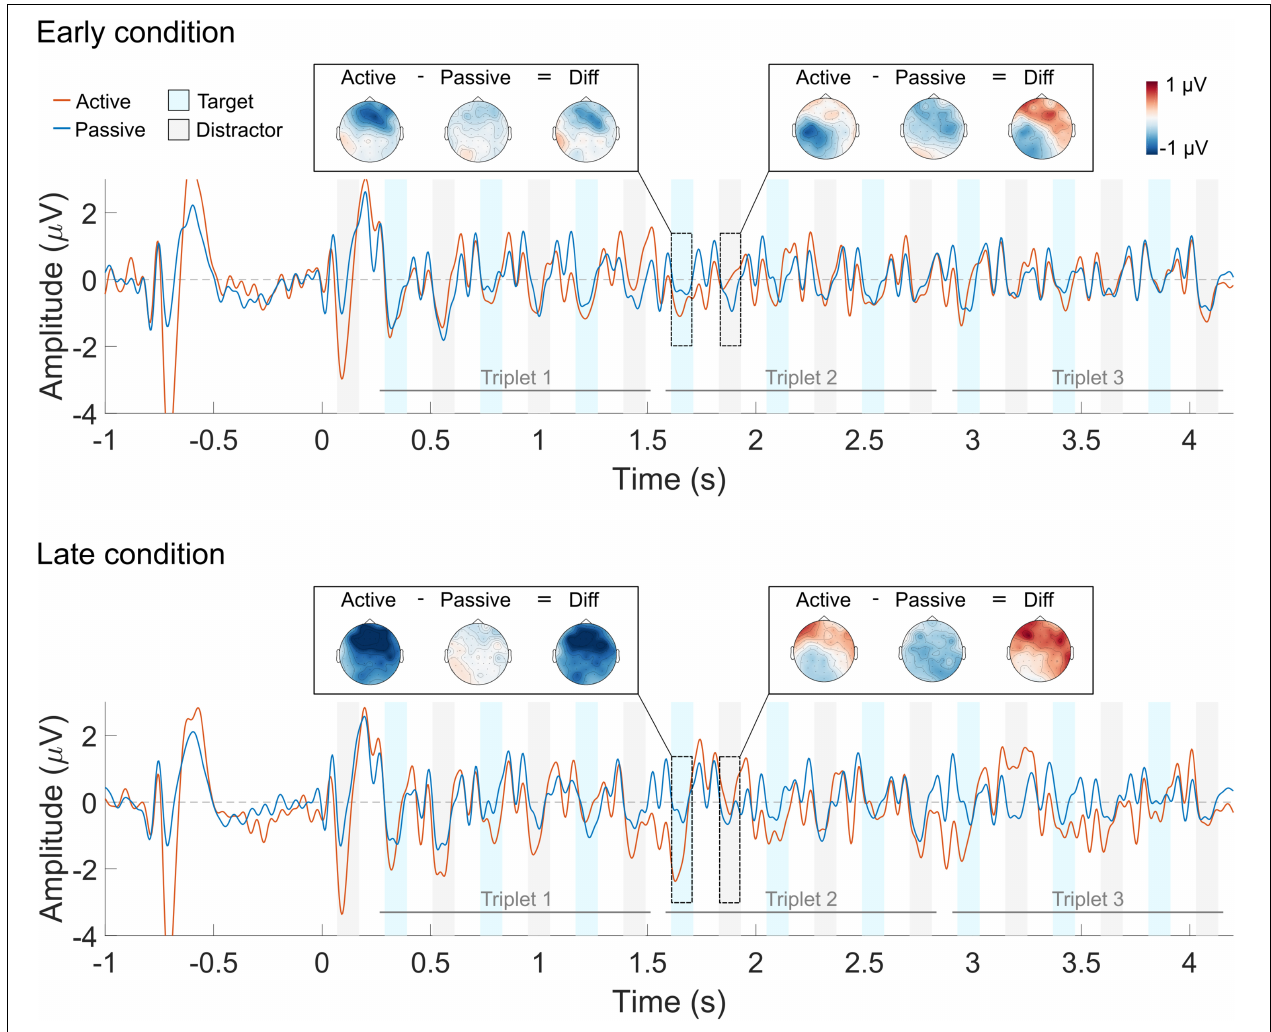
FIGURE 5 | Averaged ERP waveform for the early (top) and late (bottom) deviant conditions. The active listening condition is shown in red and the passive listening condition in blue. The blue and gray shaded areas indicate the N1 ERP component time window for the target and the distractor sounds, respectively. Each trace represents the average across nine front-central electrodes (Fz, AFz, FCz, F1, F2, FC1, FC2, AF3, AF4). The scalp topography of the response to a target and a distractor sound is shown for each of the listening conditions and their